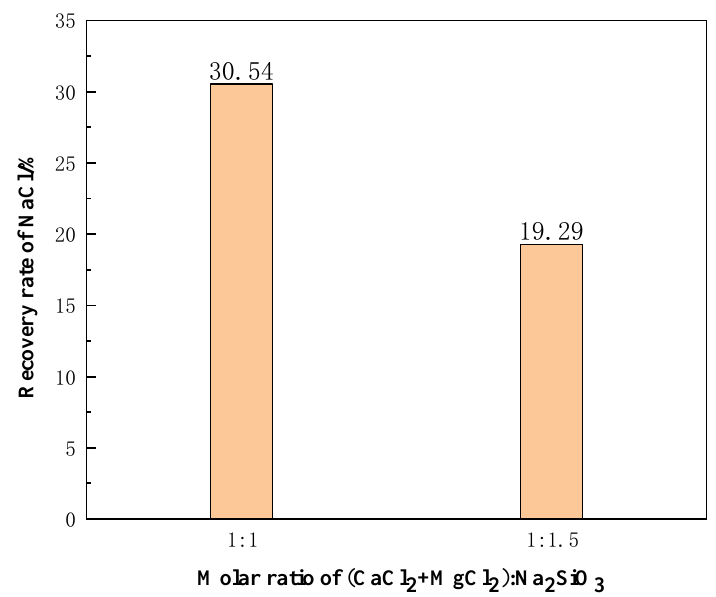
Figure 18. Effect of different additive dosages on the recovery rate of NaCl.